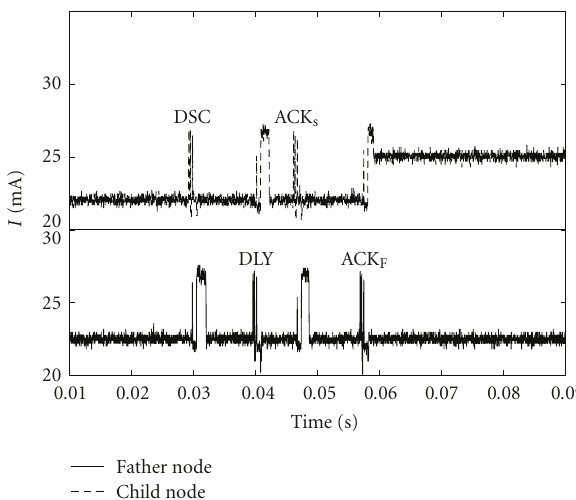
Figure 7: AAO in real implementation over CSMA/CA.